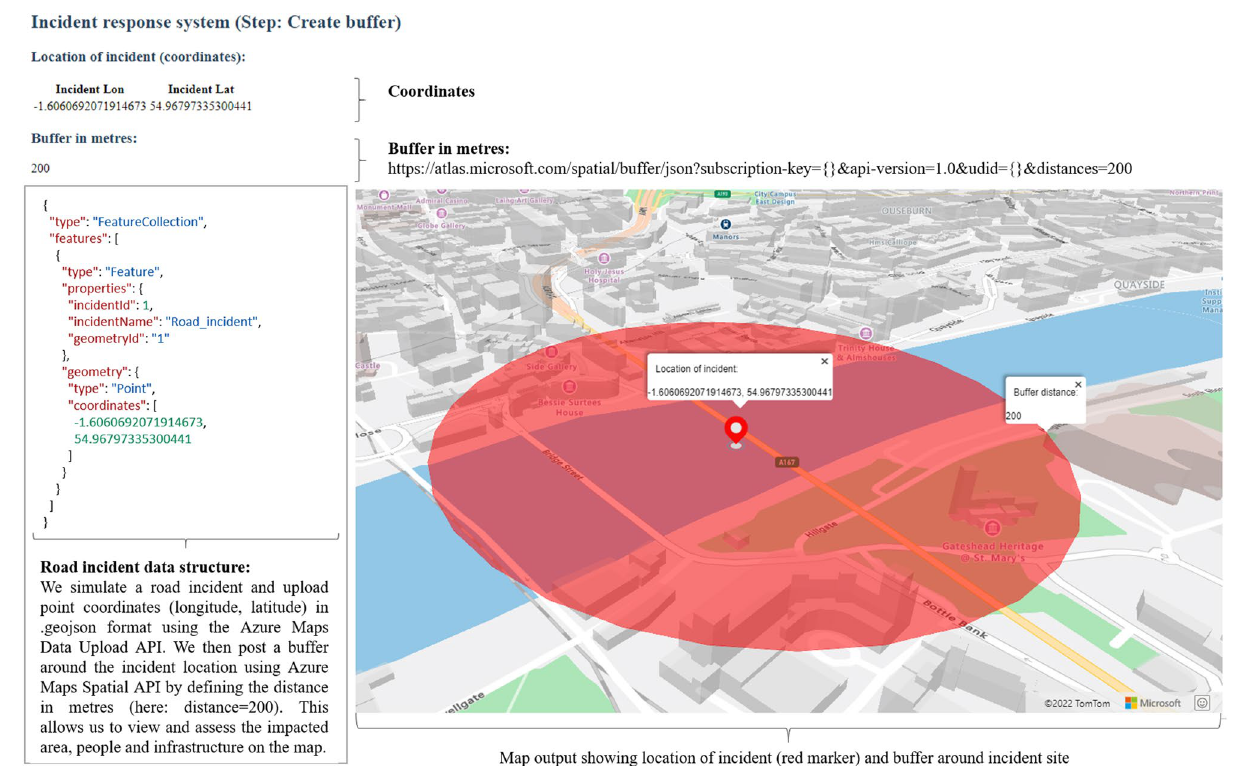
Figure 3. Incident process steps 1–2: Get incident location and create buffer (own figure). The web application shows the indicators: Location of incident (longitude, latitude) and buffer in metres. The code excerpt displays a .geojson file containing information for a simulated incident (incident ID, incident name, longitude, and latitude coordinates). The map output visualises the location of the incident on the Tyne Bridge with a red marker and a red circular buffer area around the incident location. KW created the map output using the Microsoft Azure Maps Web Software Development Kit and TomTom ( © 2022) base map data (a subscription key to use the data can be obtained after registering on the Azure Maps platform for Geospatial Mapping APIs under https:// azure. micro soft. com/ en- us/ servi ces/ azure- maps/# azure maps- overv iew). The code for the web application was developed in JavaScript, CSS and HTML in the Microsoft Visual Studio Code integrated development environment (version 1.70.2) and Node.js (version 16.13.2) on a Windows NT 64-bit operating system (×64- based processor) 40